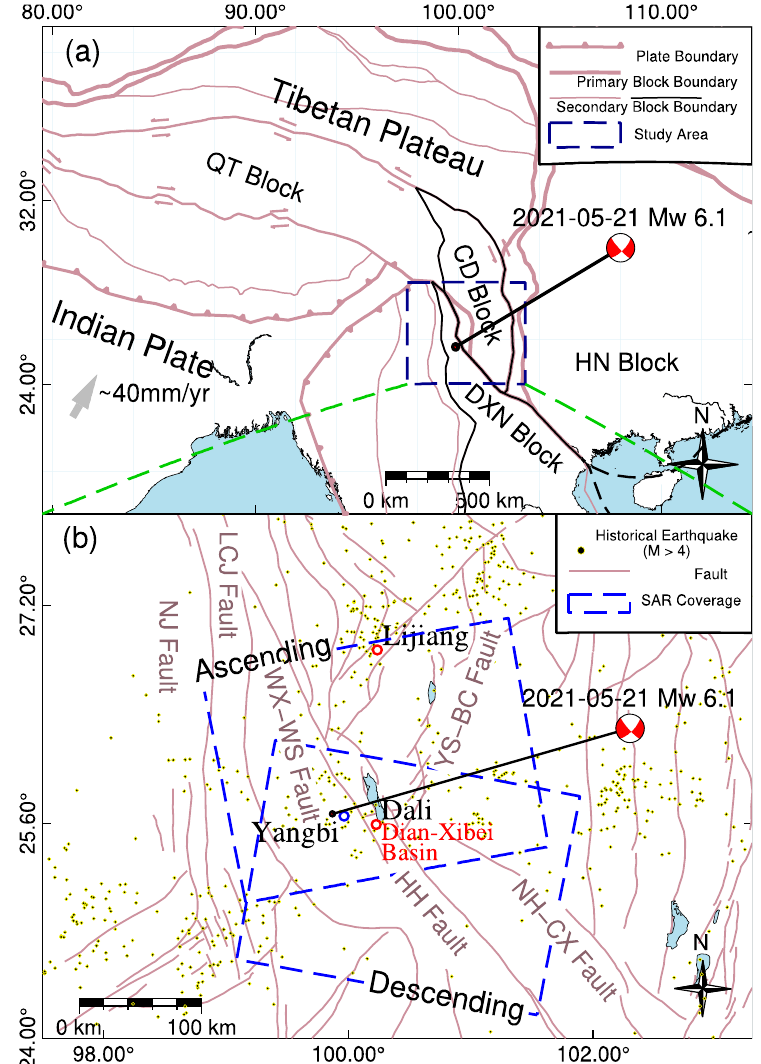
Figure 1. Seismotectonic setting and data coverage. The red beach ball shows the focal mechanism solution of the 2021 Yangbi earthquake. ( a ) QT Block, CD Block, HN Block, and DXN Block are the abbreviations of Qiangtang block, Chuandian block, Huanan block, and Dian–Xinan block, respectively. ( b ) Black dots with yellow edge color are the historical earthquakes of M > 4 since 1971. WX– WS Fault, HH Fault, NH–CX Fault, YS–BC Fault, LCJ Fault, and NJ Fault are the names of the Weixi– Weishan fault, Honghe fault, Nanhua–Chuxiong fault, Yongsheng–Binchuan fault, Lancangjiang